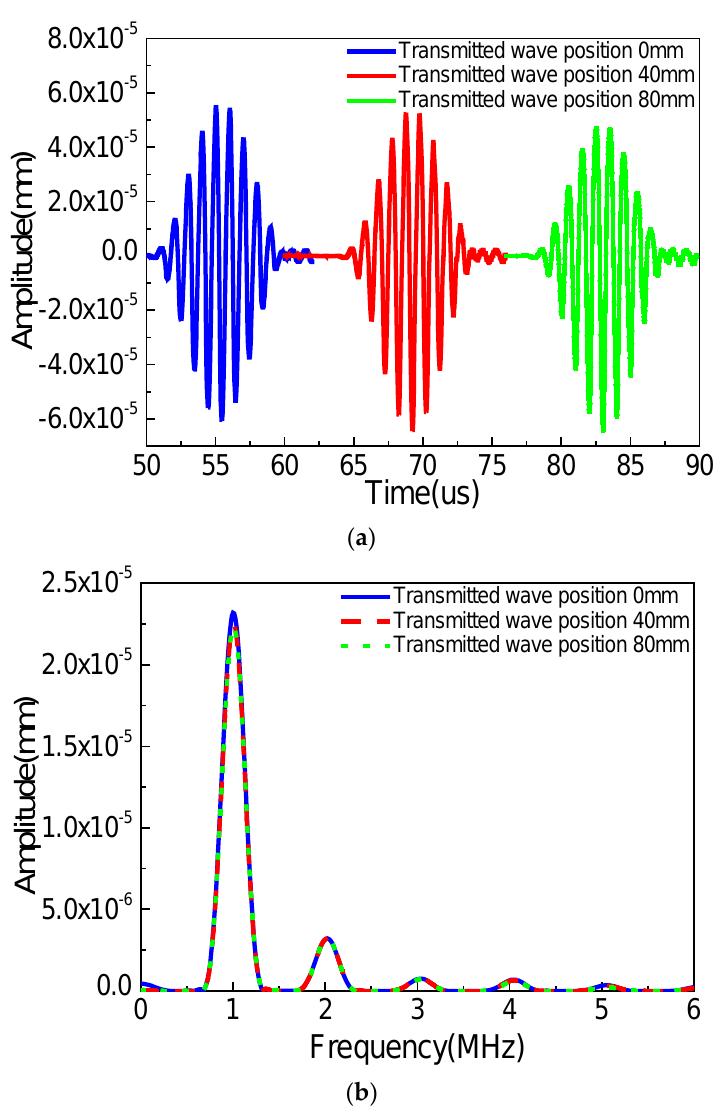
Figure 7. Waveforms of wave signals in the y direction at different locations ( a ) time domain; ( b ) frequency domain ( c = 0.1, f = 1000 kHz, µ = 0.1, % = 60%).